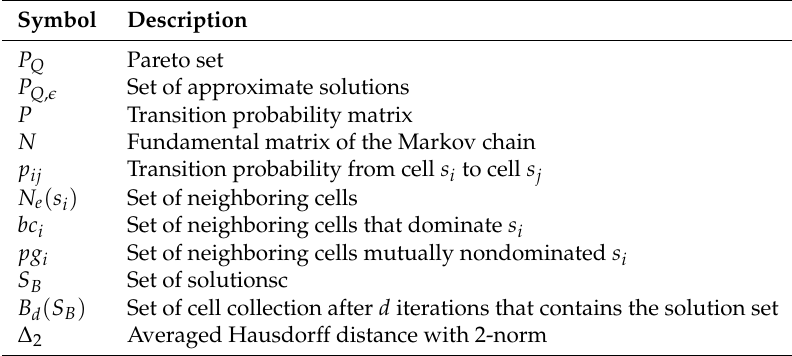
Table 1. Nomenclature of relevant variables used in the